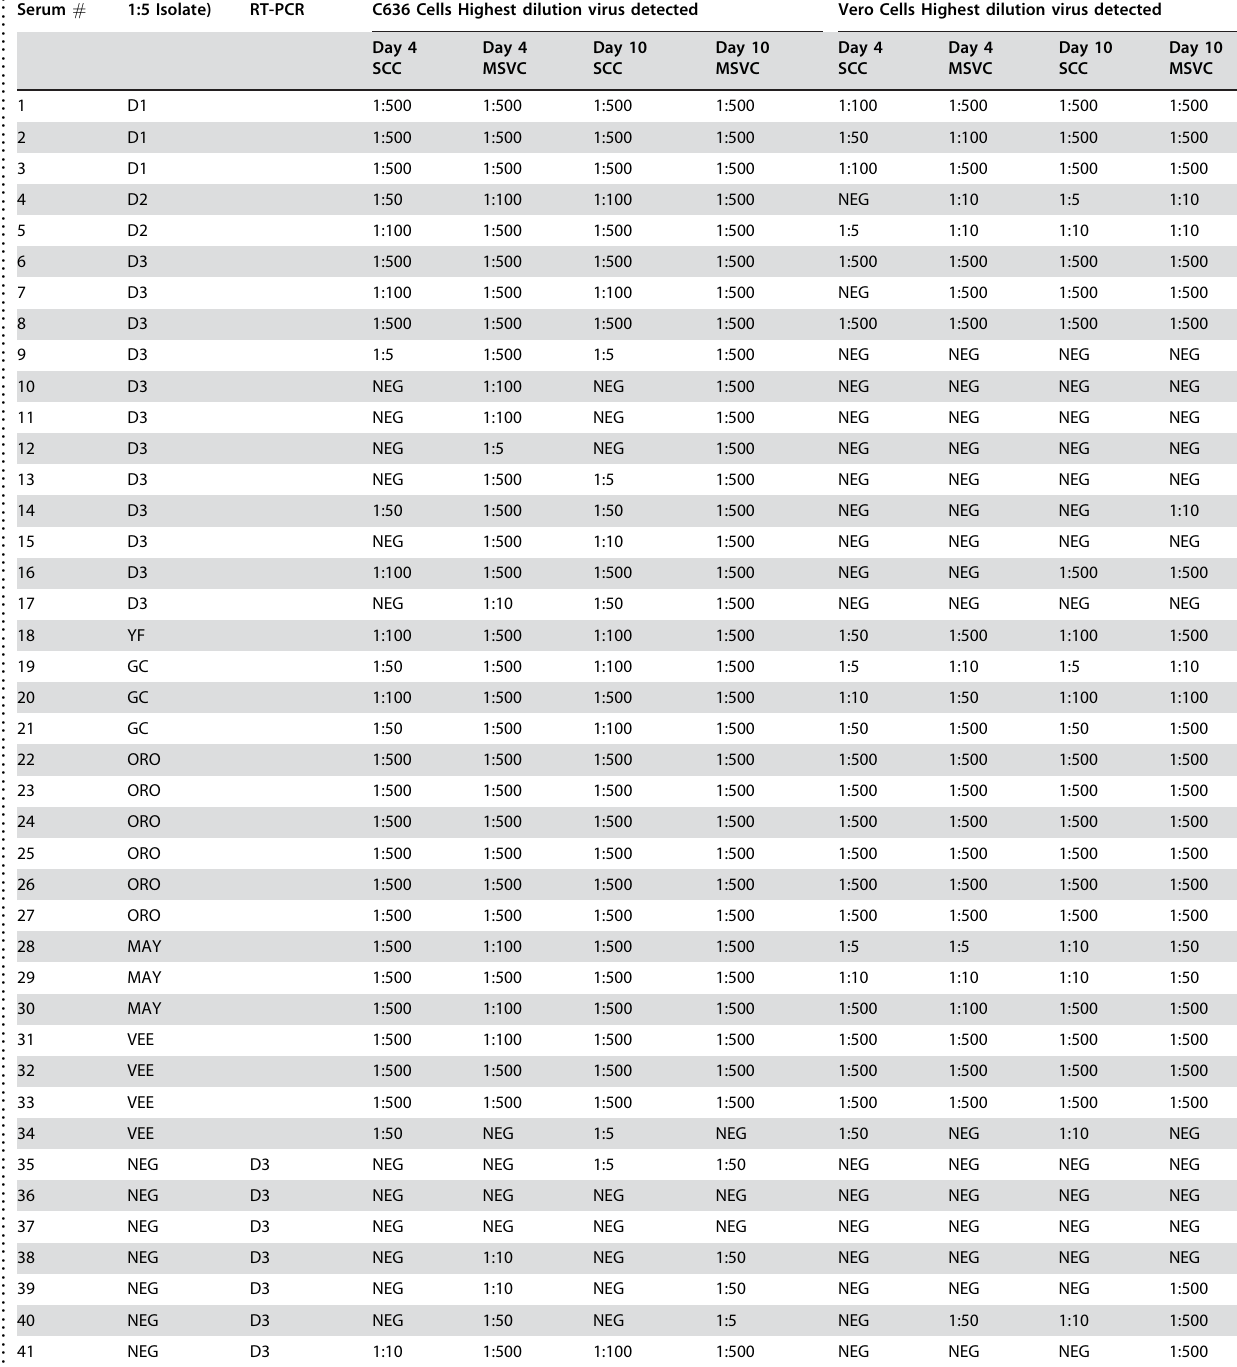
Table 2. Comparison of virus detection in sera by SCC and MSVC. .. ... .... ... ... .... ... ... .... ... ... .... ... ... .... ... ... .... ... ... .... ... ... .... ... ... .... ... ... .... ... ... .... ... ... .... ... ... .... ... ... .... ... ... . SCC (C6/36 Serum # 1:5